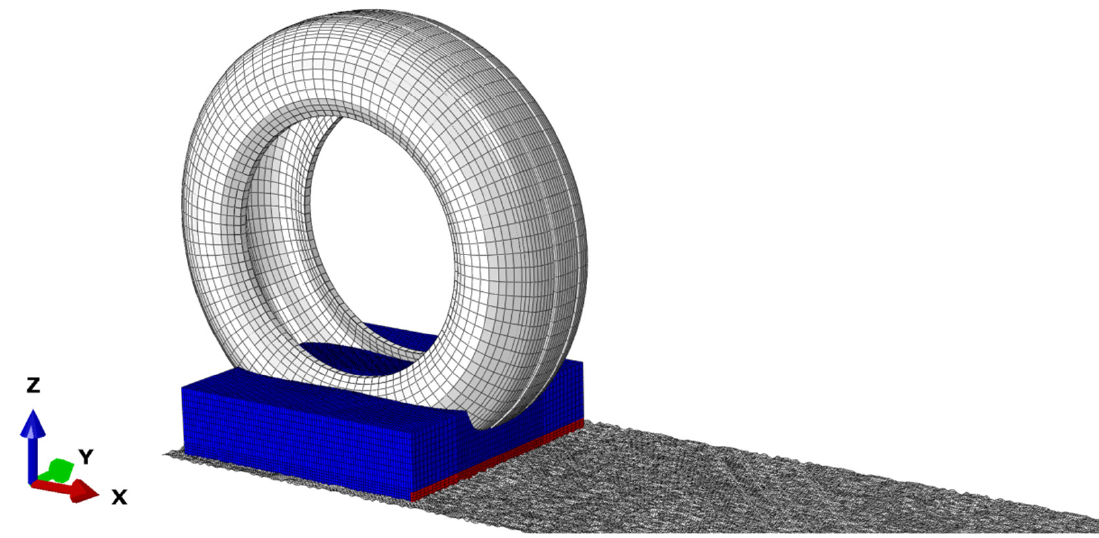
Figure 12. Tire aquaplane model on asphalt pavements.